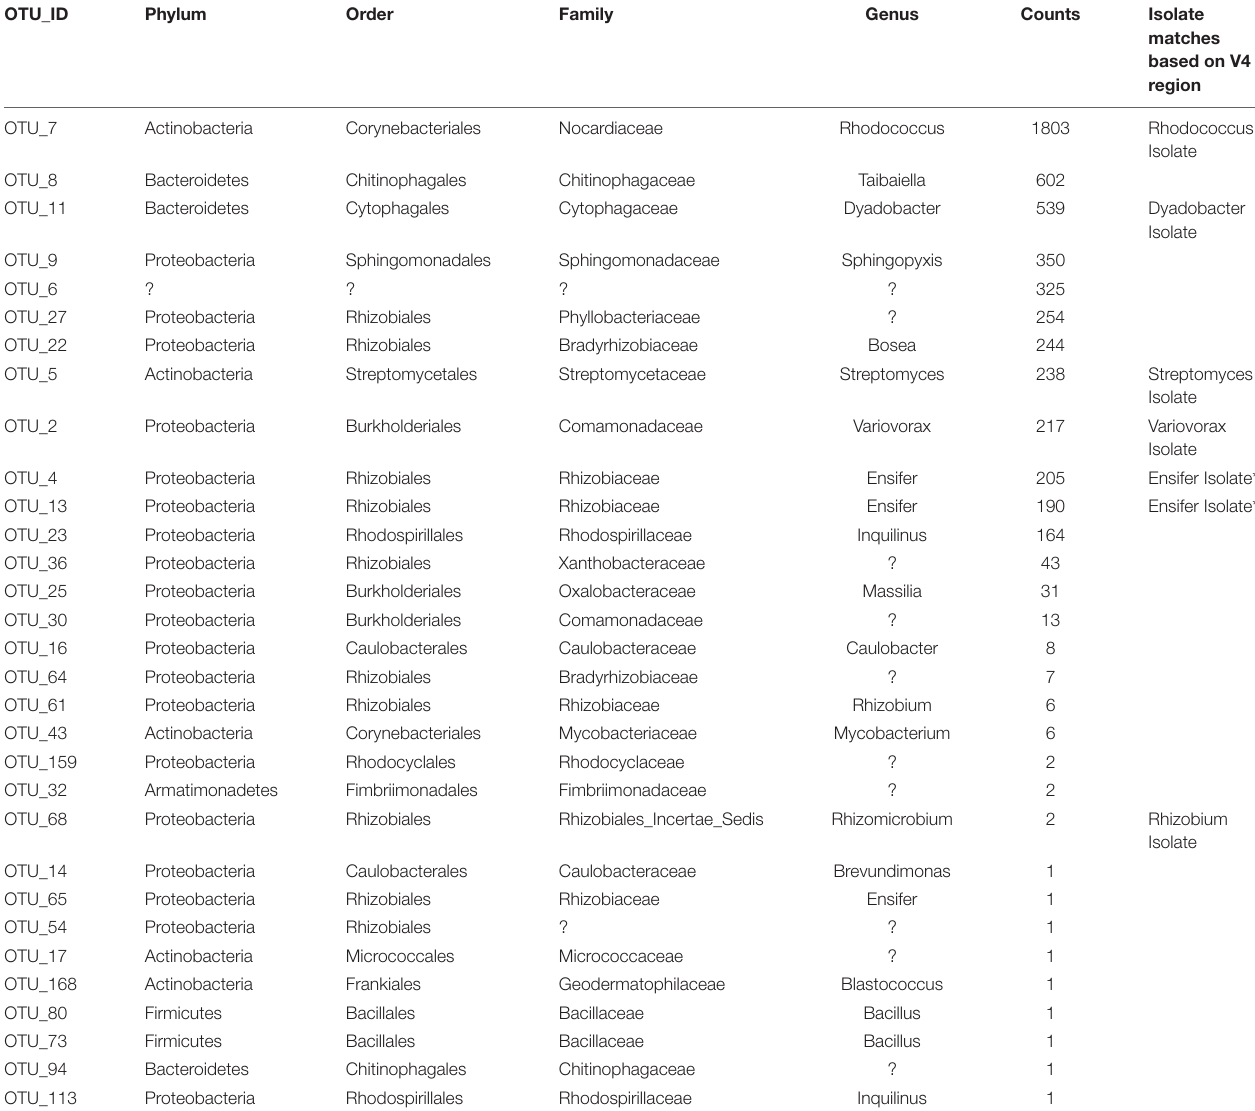
TABLE 1 | Taxonomic makeup of